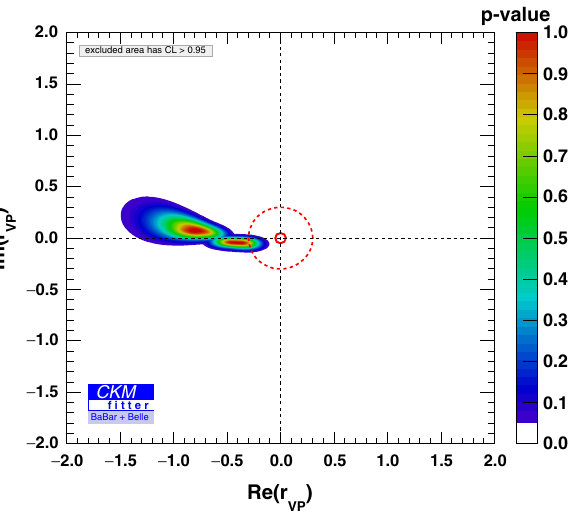
Fig. 7 Two-dimensional constraint on real and imaginary parts on the r V P parameter defined in Eq. (27). The area encircled with the solid ( dashed ) red line corresponds to the CPS/GPSZ prediction, with a 5% (30%) uncertainty on the r VP parameter